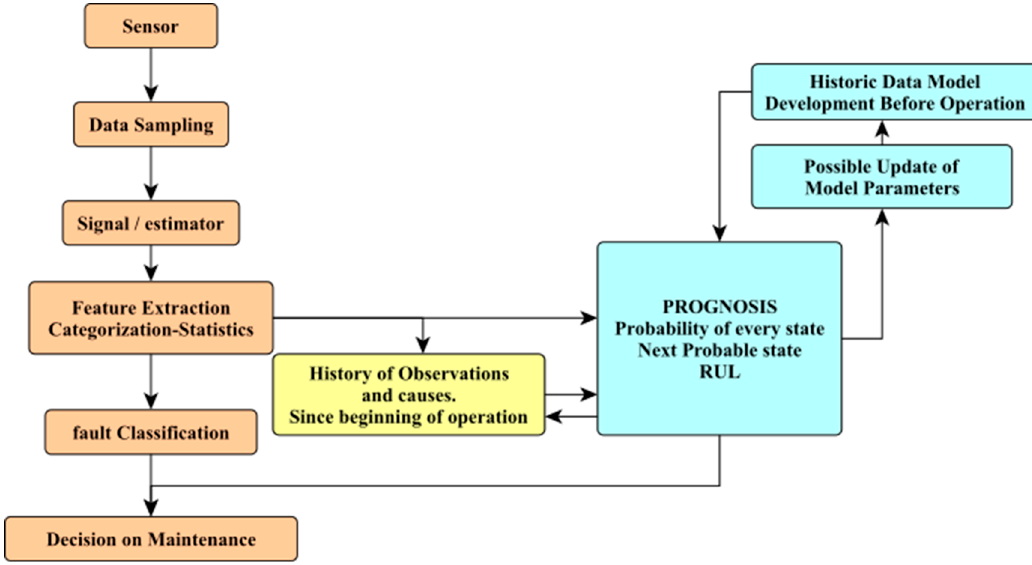
Figure 9. Schematic of the processes for failure detection, diagnosis and prognosis. Modified from [107,140].